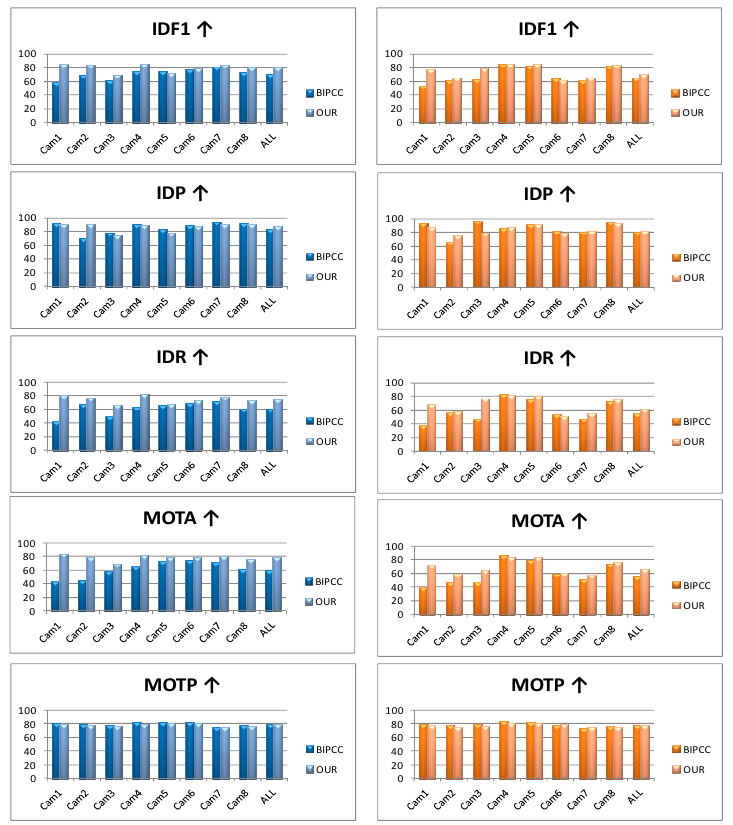
Figure 11. Comparison between the benchmark and ours. The IDF1, IDP, IDR, MOTA and MOTP arranged from top to bottom, and the bar graphs on the left are the results of test-easy set, the rights are the results of test-hard